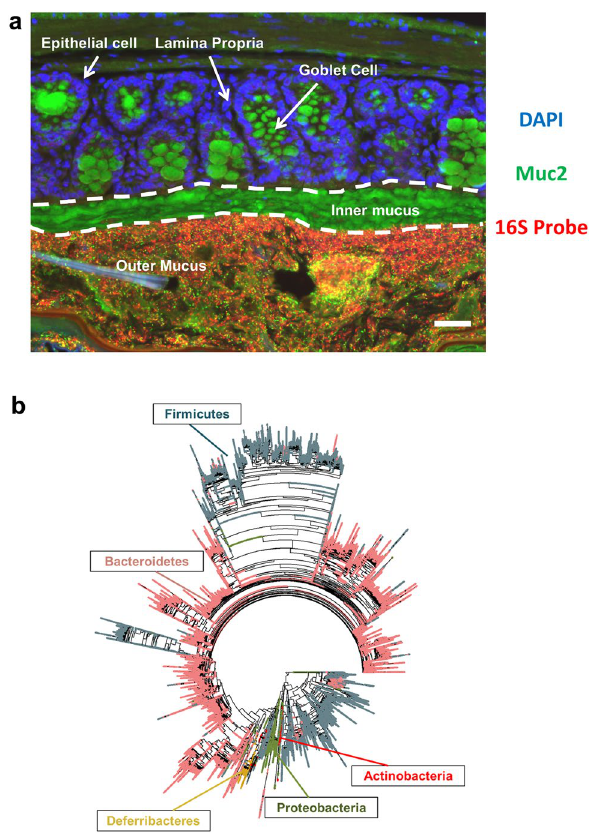
Figure 1. Distribution of phyla across the phylogenetic tree. Colonic tissue sections from a male wildtype (WT) mouse was stained with a fluorescent DNA probe specific for the 16S rRNA gene to identify bacteria (red), a Muc2 antibody (green) to identify mucus and counterstained with DAPI (blue) ( a ). A phylogenetic tree of 16S rRNA sequences derived from the gut microbiota of FVB wildtype (WT) mice and mdr1a −/− mice ( b ). The distribution of major gut phyla are highlighted on the tree: Firmicutes (grey), Bacteroidetes (pink), Proteobacteria (olive), Actinobacteria (red), and Deferribacteres (gold). The same tree is shown, coloured by other criteria, in Supplementary Figure S1. Figure ( b ) was produced in R 3.6.0 for